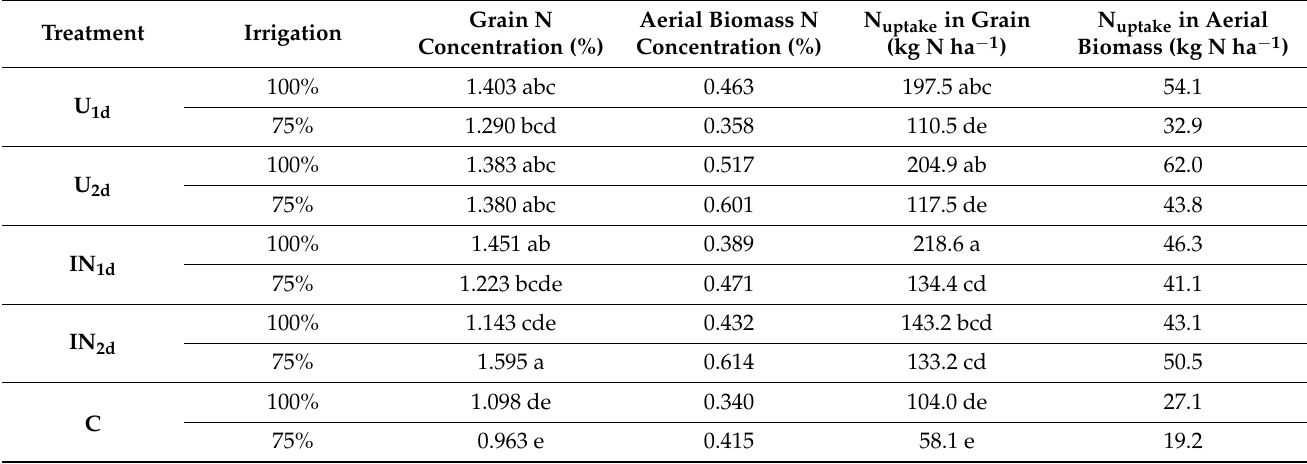
Table 3. N concentration and N uptake in grain and aerial biomass from optimal (100%) and sub-optimally (75%) irrigated maize. Letters indicate statistical differences between treatments ( p < 0.05). Treatments were a combination of urease inhibitor use (In), simple urea use (U), or no fertilizer (C), with fertilizer application in one (1 d) or two (2 d) dressings and optimally irrigated (100%) or sub-optimally irrigated